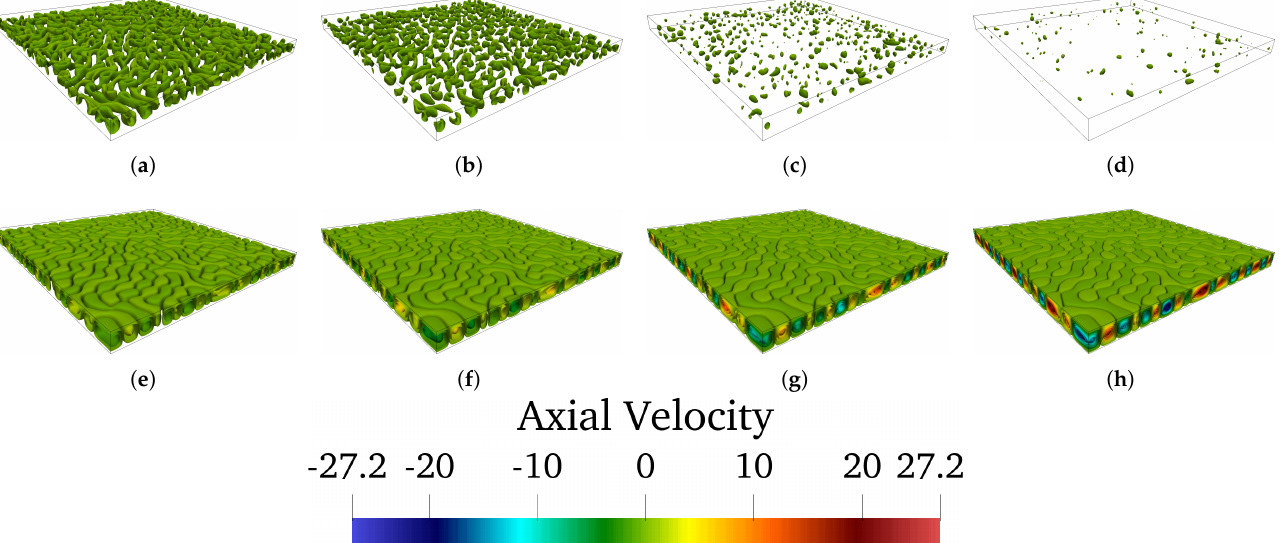
Figure 7. Thermovibrational convection in a layer of FENE-CR fluid delimited by differentially heated solid walls (snapshots of the isosurfaces of the vertical component of velocity evenly distributed over the interval I 2 ). Pr g = 8, Ω = 25, Ra ω = 4000, ξ = 0.5, ϑ = 0.1, pulse wave